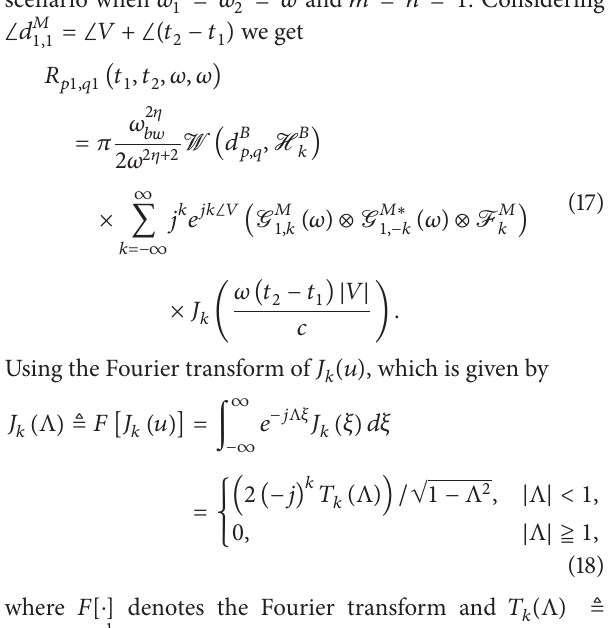
Figure 3: CCF corresponding to WB and UWB signals with directional APP, Laplace, and von-Mises PDFs of the propagation environment, with antenna spacing 𝜆/2 = 𝑐𝜋/𝜔 𝐻 and frequency offsets Δ𝑓 = 𝑓 2 − 𝑓 1 . Laplacian distribution, for both WB and UWB channels.